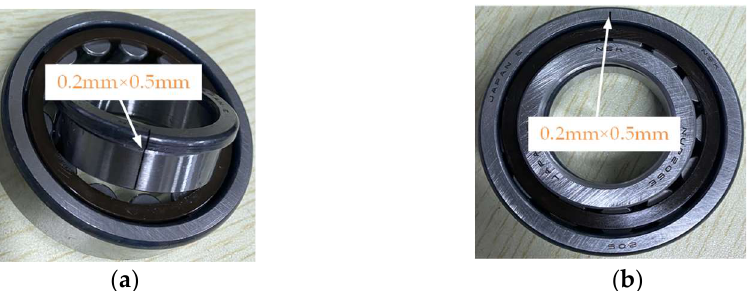
Figure 5. The test rig for the defective bearing with fit clearance.